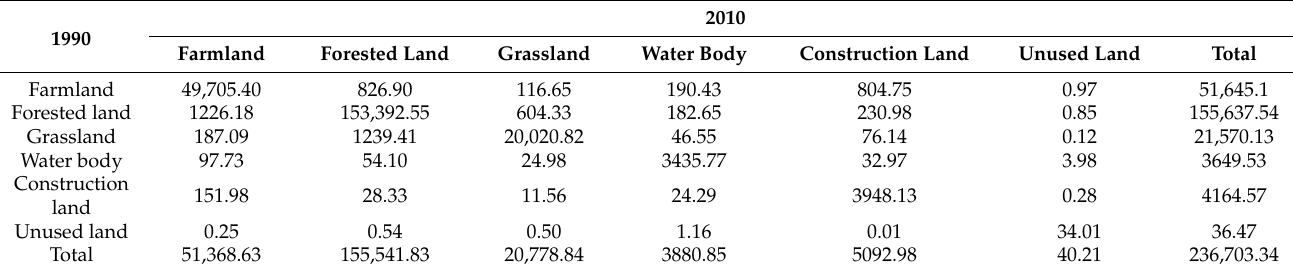
Table 2. Land use change matrix of Guangxi during 1990–2010 (ha).